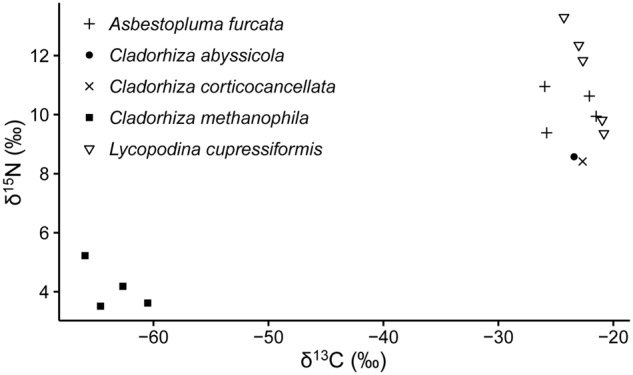
Stable isotope values of carbon (δ13C) and nitrogen (δ15N) of a selection of cladorhizids collected at the Troll Wall vent field, and the BAP diapiric field.